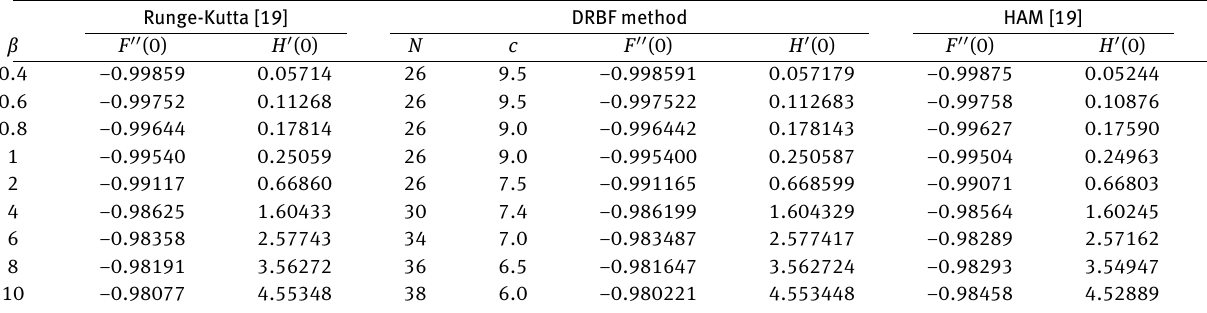
Table 2: Comparison between direct RBFs and other solutions of F (cid:48)(cid:48) (0) and H (cid:48) (0) for some β at ε = 0.1 and ϕ = 0 . Runge-Kutta [19]